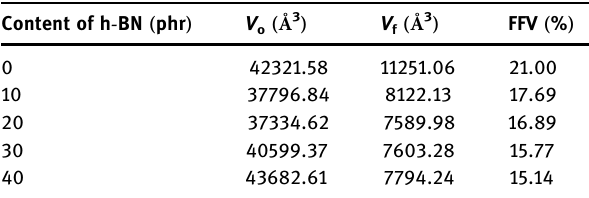
Table 5: h - BN/EP composite FFV with di ff erent h - BN content Content of h - BN ( phr